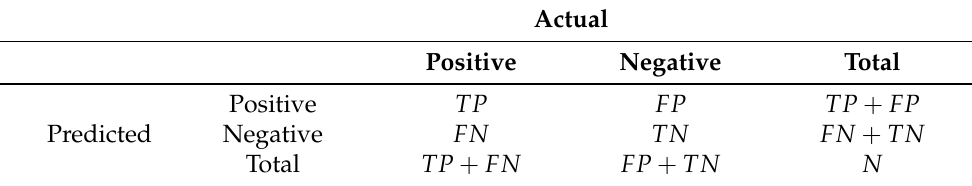
Table 3. Confusion matrix of classification